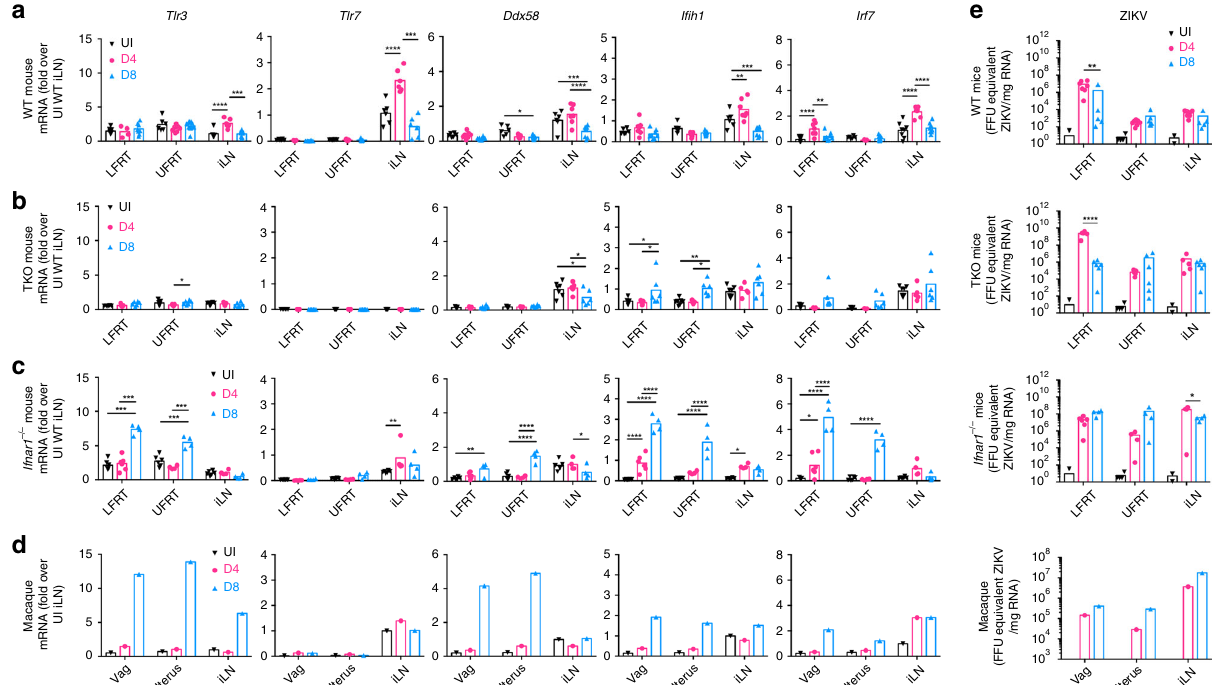
Fig. 7 IFNAR signaling is required to limit viral dissemination from LFRT to other tissues. Female mice or macaques were i.vag. inoculated with ZIKV, and tissues were collected at day 4 or 8 post-infection. Indicated genes in total RNA were detected using qRT-PCR from ( a ) C57BL/6N WT (UI n = 6 – 7, D4 n = 7 except LFRT, D4 LFRT n = 4, D8 LFRT and iLN n = 8, and D8 UFRT n = 11 mice), ( b ) Tlr3 − / − Tlr7 − / − Mavs − / − TKO mice (UI n = 5, D4 n = 5, D8 n = 6 animals), ( c ) Ifnar1 − / − mice (UI n = 6, D4 LFRT n = 6, D4 UFRT and iLN n = 4, and D8 n = 4 animals), or ( d ) macaques (UI sample was pooled from samples shown in Fig. 4 for reference, one animal each for D4 and D8), normalized to GAPDH, and expressed as fold-changes over iLN samples from naïve animals. ( e ) ZIKV RNA was detected by qRT-PCR in total RNA from the indicated tissues of WT (D4 n = 7 and D8 n = 5), TKO (D4 n = 5 and D8 n = 6), and Ifnar1 − / − (D4 n = 4 and D8 n = 4) mice. UI WT mice ( n = 4) were used to determine the background level of the qRT-PCR assay. All female mice were treated with 1.0 mg DMPA followed by i.vag. infection a week later. Previously described macaques were treated with 30 mg of DMPA 4 weeks prior and on the day of infection 20 . The historical ZIKV RNA levels in the macaque tissues have been re-plotted. Data represent mean ± SEM; * p < 0.05, ** p < 0.01, *** p < 0.001, **** p < 0.0001; two-way ANOVA with Tukey ’ s multiple comparison test. Each dot represent value from one animal and each time-point represents data from a separate group of animals. Vag, vagina (macaque equivalent of LFRT in mice); iLN, iliac lymph node; LFRT, lower female reproductive tract; UFRT, upper female reproductive tract; UI, uninfected. Source data for Fig. 6a – d are provided as a Source Data fi